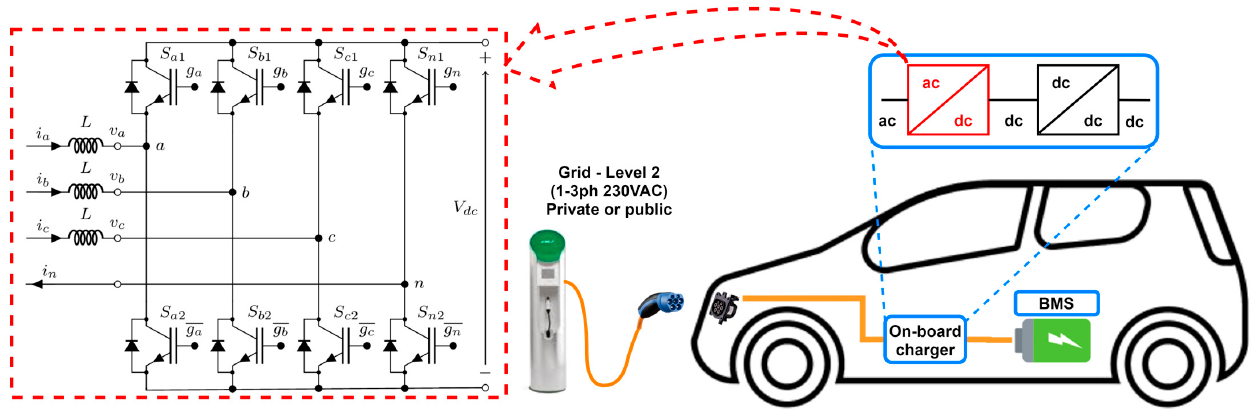
Figure 1. On-board charger with a four-leg three-phase front-end converter.